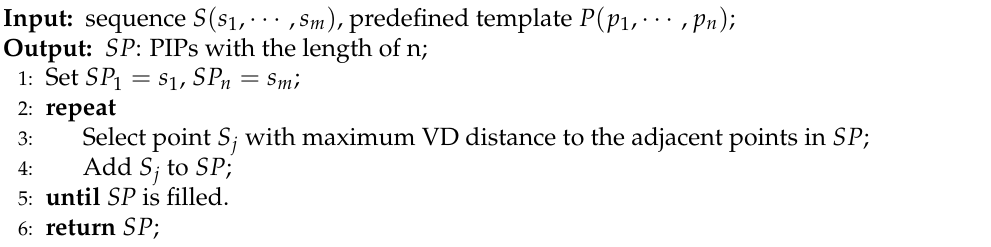
Algorithm 1 Perceptually important point identification with VD measure.